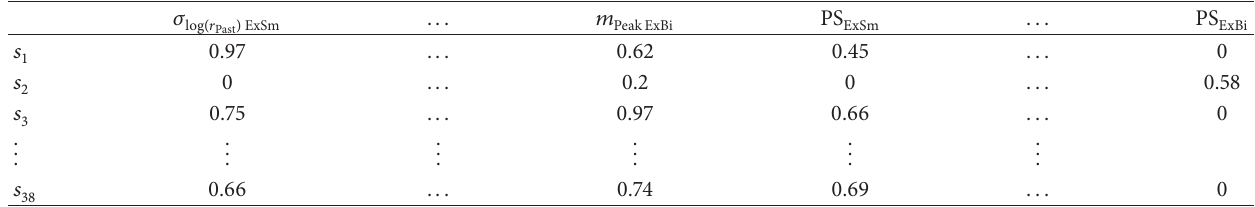
Table 7: Example of a part of the fuzzy GUHA table for peak shift of PS of the peak forecasted by the Math-1D model. Objects 𝑠 𝑖 are particular simulations.